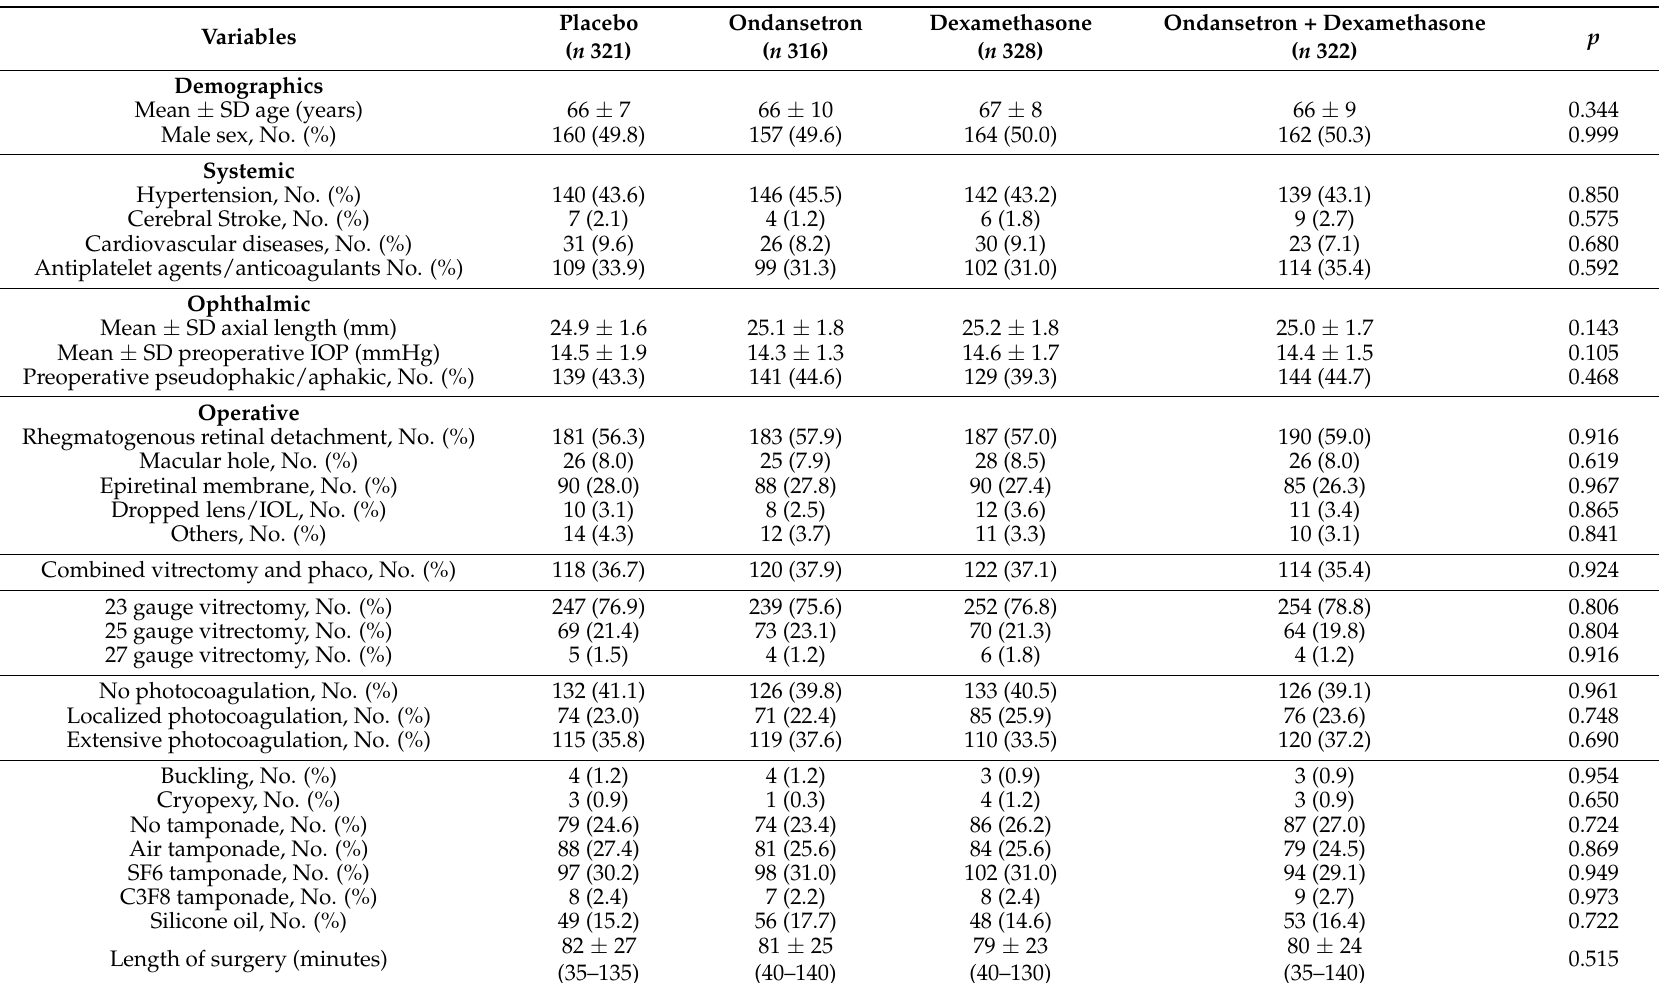
Table 1. Baseline demographic and systemic characteristics, preoperative and intraoperative